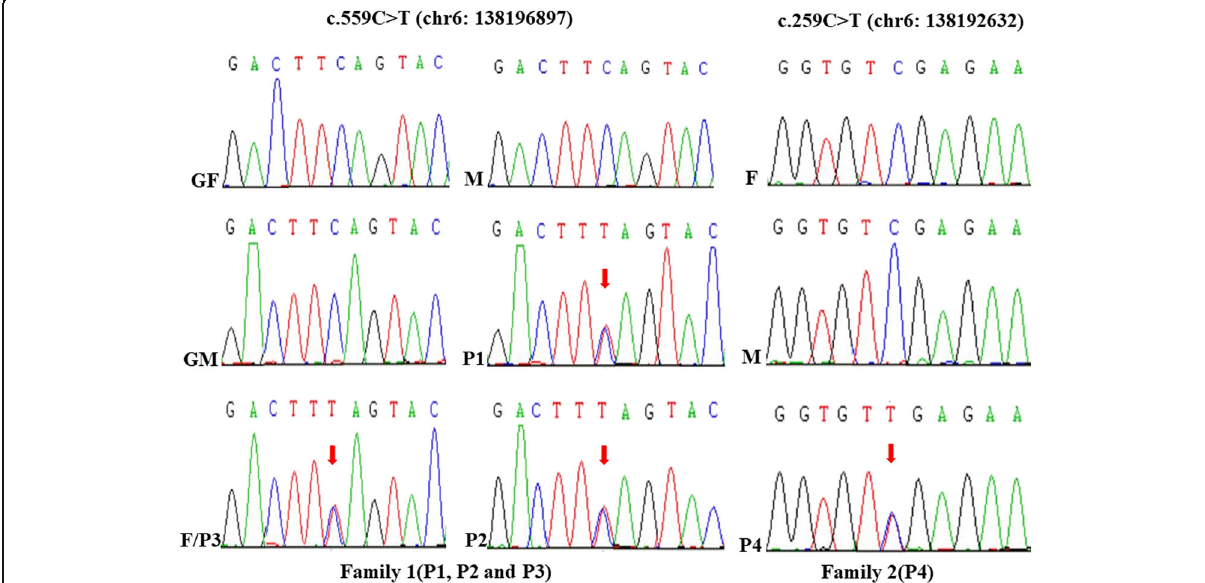
Fig. 3 Mutation analysis in TNFAIP3 gene in family 1 and family 2. P: patient; F: father; M: mother; GF: grandfather; GM: